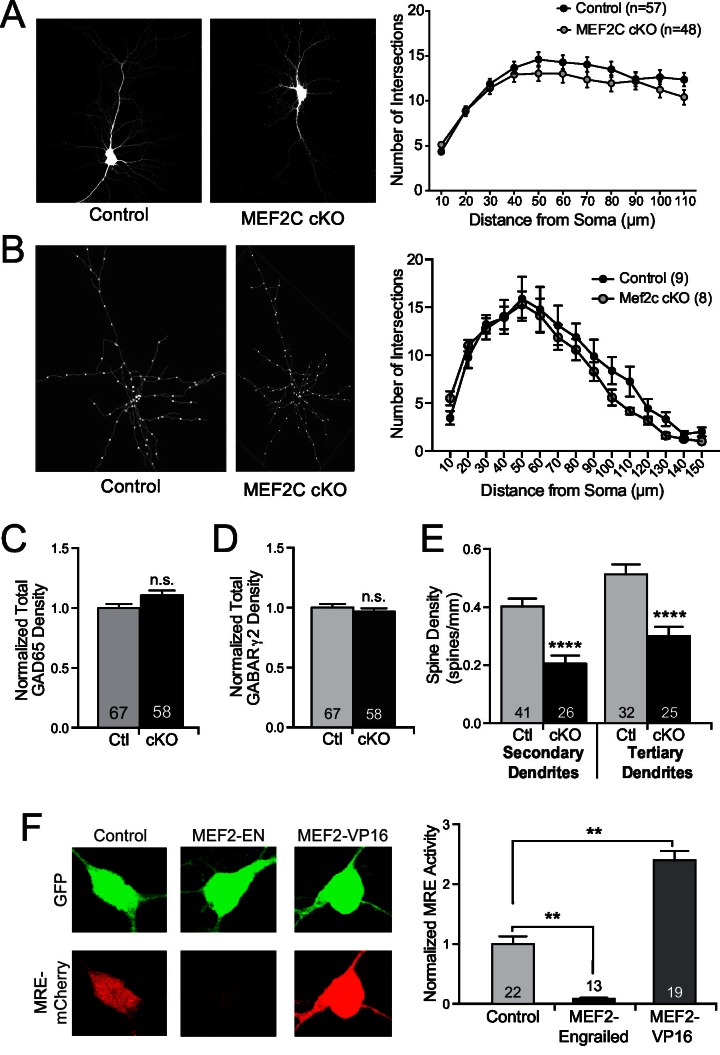
Structural synaptic changes in Mef2c cKO neurons.(A) Representative images of GFP-transfected primary cortical neurons at DIV18. Sholl analysis of pyramidal neurons at DIV18 reveals no significant changes in dendritic complexity in Mef2c cKO neurons in vitro. n=57 neurons for control and n=48 neurons for Mef2c cKO. (B) Representative traces of in vivo golgi-stained cortical layer 2/3 pyramidal neurons from somatosensory cortex in adult mice. Sholl analysis of pyramidal neurons reveals no significant changes in dendritic complexity by genotype. n=9 neurons from 3 control animals and n=8 neurons from 3 Mef2c cKO animals. (C−D) Immunocytochemical analysis of inhibitory GAD65-presynaptic (B) and GABARγ2-postsynaptic (C) puncta in cultured cortical neurons at DIV18. Cortical neurons from Mef2c cKO mice show no change in inhibitory presynaptic puncta (GAD65 positive) or postsynaptic puncta (GABARγ2 positive) compared to controls as measured by co-localization of GAD65 (presynaptic) and GFP (neuron mask). (E) Mef2c cKO neurons have fewer dendritic spines than control neurons. Primary cortical neurons were grown to DIV18, and spines were visualized using myristoylated-GFP. Reduced spine density was observed in both secondary and tertiary dendrites, resulting in an overall reduction in spine density in all dendrites (Figure 3B). Numbers of dendritic stretches (n) are reported in each bar from at least 30 control and 22 Mef2c cKO neurons. (F) MEF2C-Engrailed and MEF2C-VP16 regulate MEF2 transcriptional activity in cultured cortical neurons. (left) Representative images of 3XMRE-mCherry expression in cortical neurons transfected with either empty vector, MEF2C-EN or MEF2C-VP16. (right) Quantification of average 3XMRE-mCherry intensity normalized to GFP intensity. Data are represented as mean ± SEM. Statistical significance was determined by repeated measures ANOVA (A,B), unpaired t-test (C–E), or one-way ANOVA followed by Kruskal-Wallis post-hoc test (F). **p<0.01, ****p<0.0001, ns=not significant.